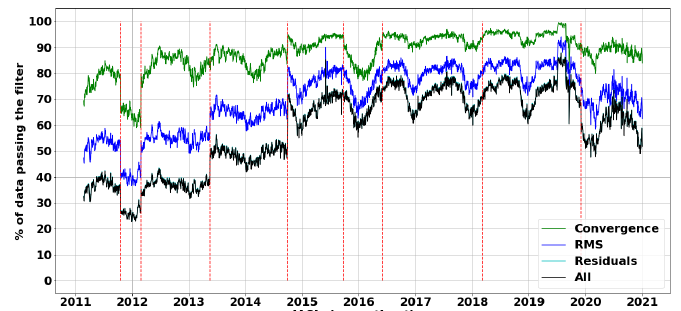
Figure 3. Statistics on the NOPIR quality control filtering (with previous cloud filtering) as a function of observation date. The cyan curve (filtering on each spectral residual) falls below the black curve (all filters applied). Red vertical lines relate to dates in Table 1, linked to changes in the EUMETSAT IASI operational level 2 processing. A red line has also been added for 16 May 2013, when an update in the EUMETSAT IASI operational level 1 processing occurred [76],which clearly influences the NOPIR retrieval